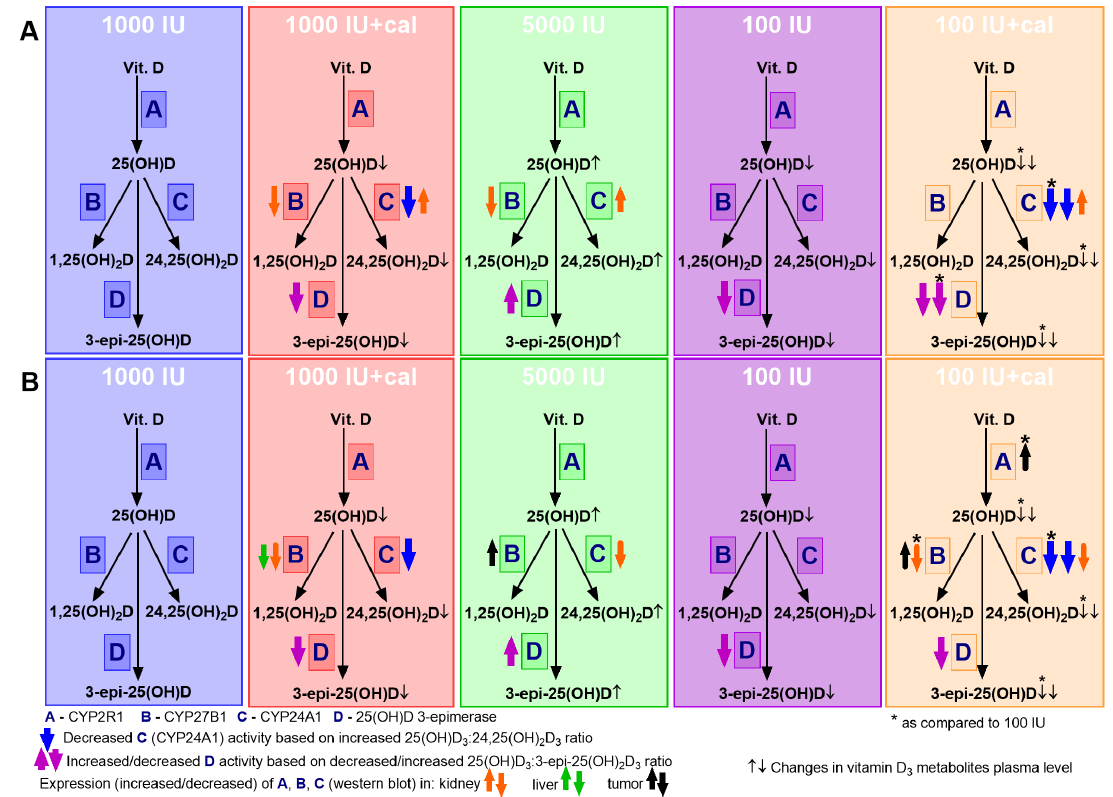
Figure 10. Summary of the elements of vitamin D metabolism studied in mice in various experimental conditions. All changes are indicated as compared to control (1000 IU) with the exception of those marked with *, which are compared to 100 IU ( A ) healthy; ( B ) E0771 tumor-bearing C57BL/6 mice.